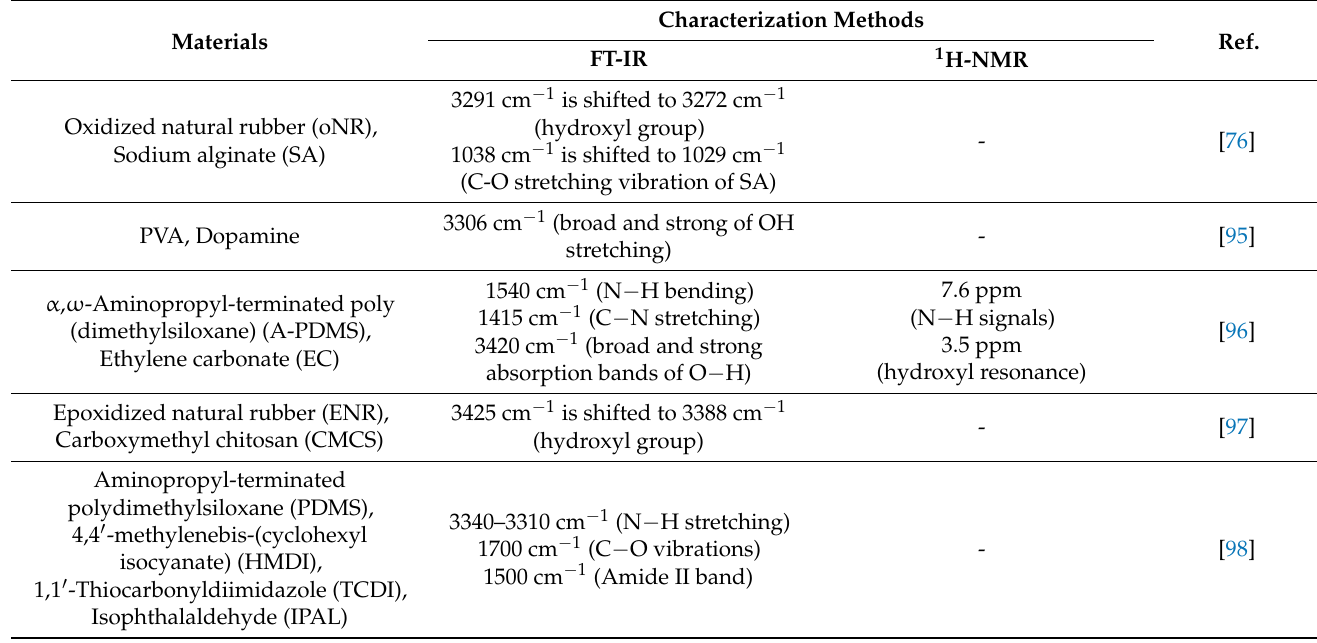
Table 3. Overview of characterization methods for